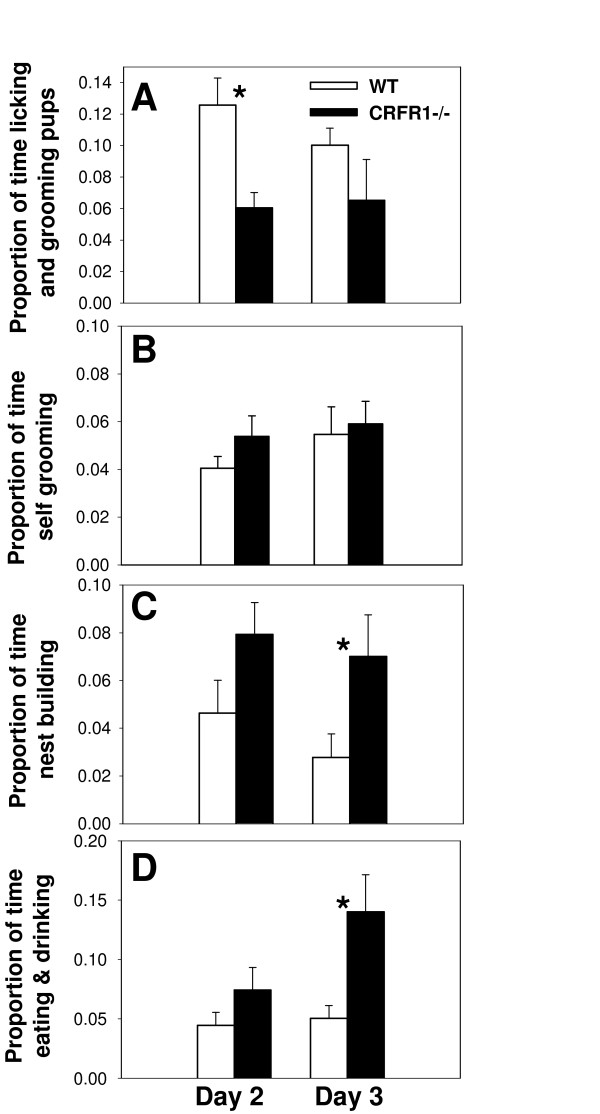
Analysis of maternal and non-maternal behaviors in WT and CRFR1-/- mice. CRFR1-/- mice spent a significantly lower proportion of time licking and grooming offspring postpartum Day 2 relative to WT mice, but differences between groups on Day 3 did not reach significance (A). Self grooming behavior did not differ between genotype on either test day (B). CRFR1-/- mice spent a higher proportion of time nest building than WT mice and these differences reached significance on postpartum Day 3 (C). CRFR1-/- mice spent a higher proportion of time eating and drinking than WT mice and these differences reached significance on postpartum Day 3 (D). Bars represent means ± SE. White bars indicate WT mice and black bars indicate CRFR1-/- mice. * = p < 0.05; ANOVA on ranks for (A), (C), and (D).